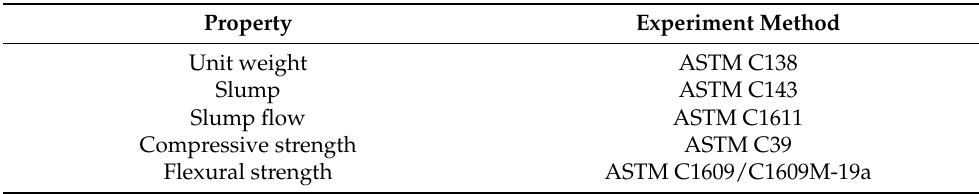
Table 6. The test methods of the fresh and hardened properties of the UHPC.